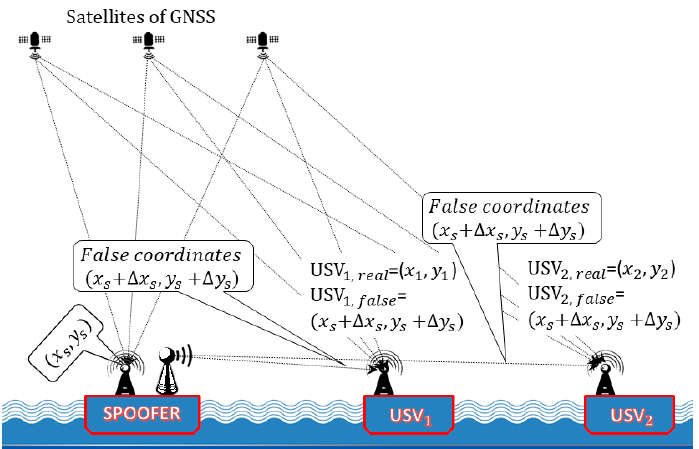
Figure 6. The basic GNSS spoofing scheme of USVs: at some point in time, the spoofer determines its position ( x s , y s ) , introducing some delays into each of the satellite channels, introducing some other signal distortion, and transmitting the false position ( x s , y s ) on the same frequency, which aims to deceive GNSS receivers and create a false PVT solution. All USVs in the spoofer activation zone are positioned as USV i , false = ( x s + ∆ x s , y s + ∆ y s ).